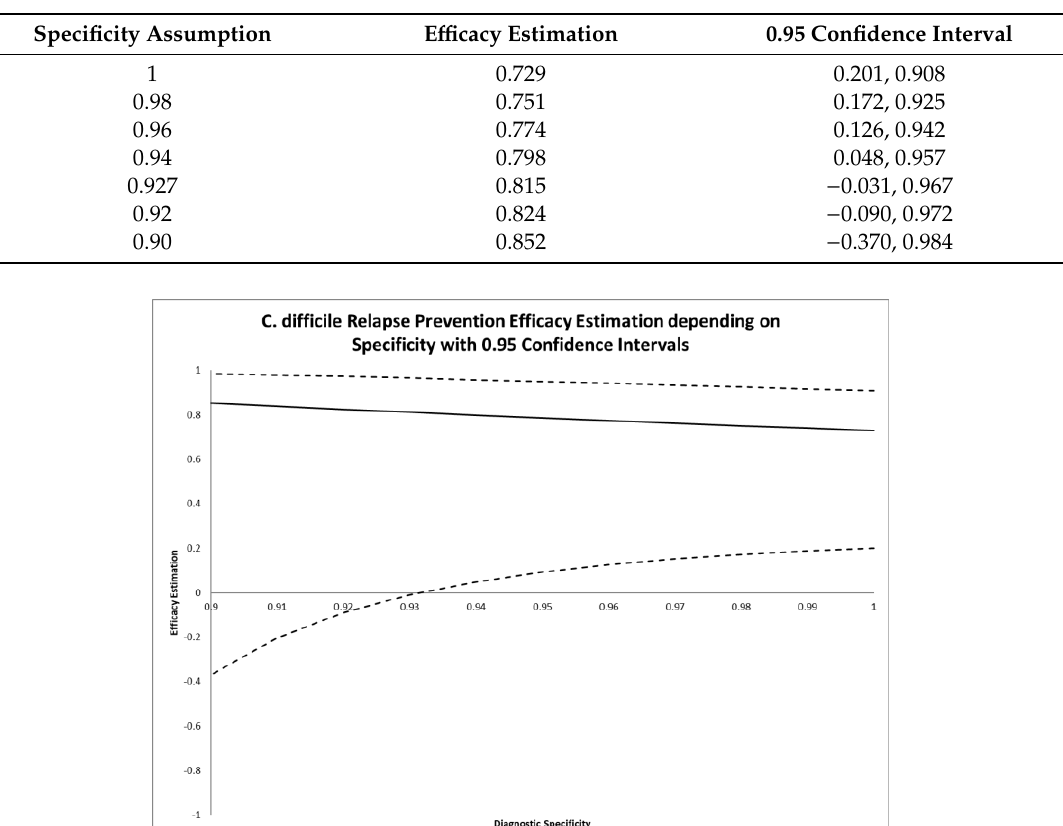
Table 2. Clostridium di ffi cile relapse prevention e ffi cacy estimates depending on specificity assumptions using Equations (7) and (9).